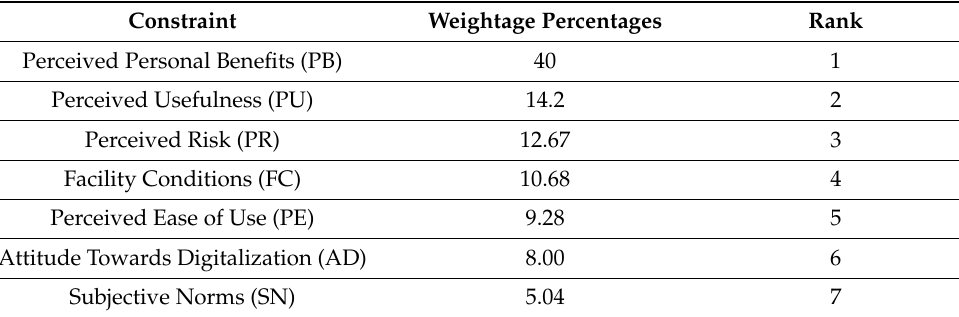
Table 4. Prioritizing the